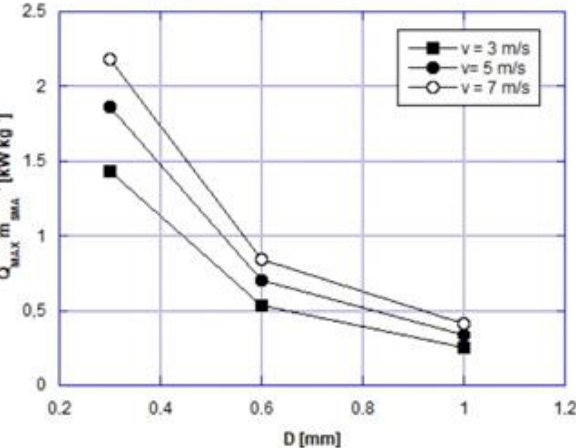
Figure 4. Estimate of the maximum cooling power per mass unit in a wire vs. the diameter, parametrized for air velocity.